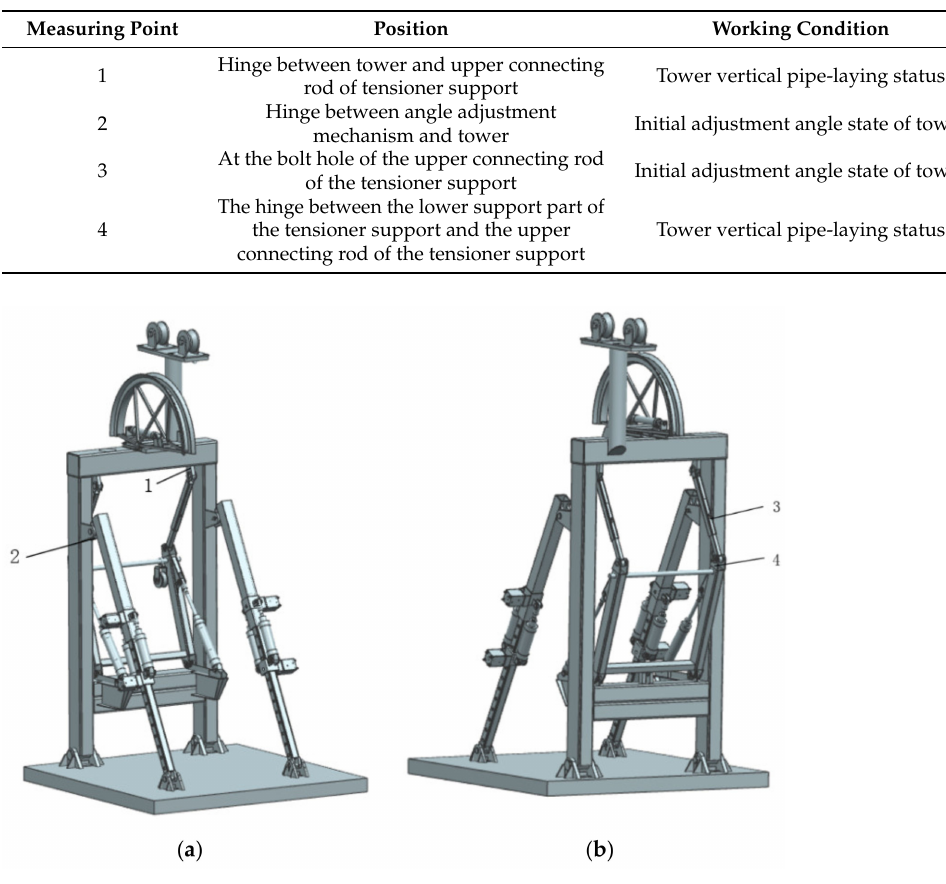
Figure 23. Location of measuring points on the mounting side of the tower ( a ) and the laying side of the tower ( b